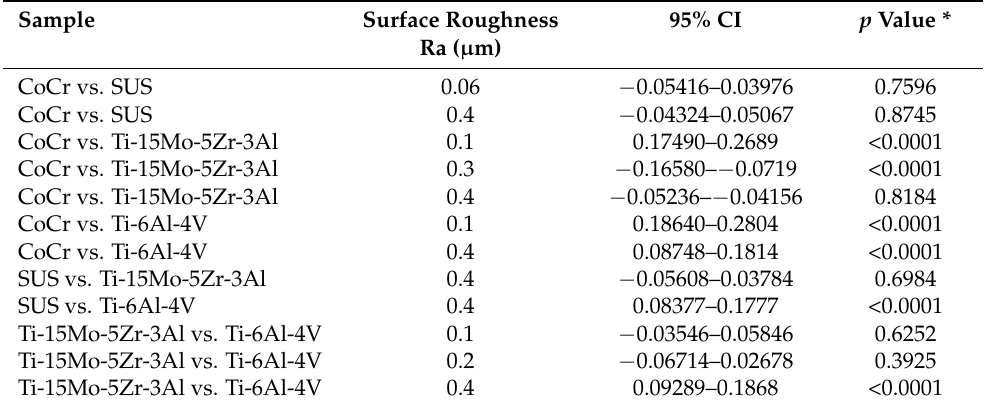
Table 4. Comparisons of frictional coefficient using Palacos R (Heraeus Kulzer, Wehrheim,